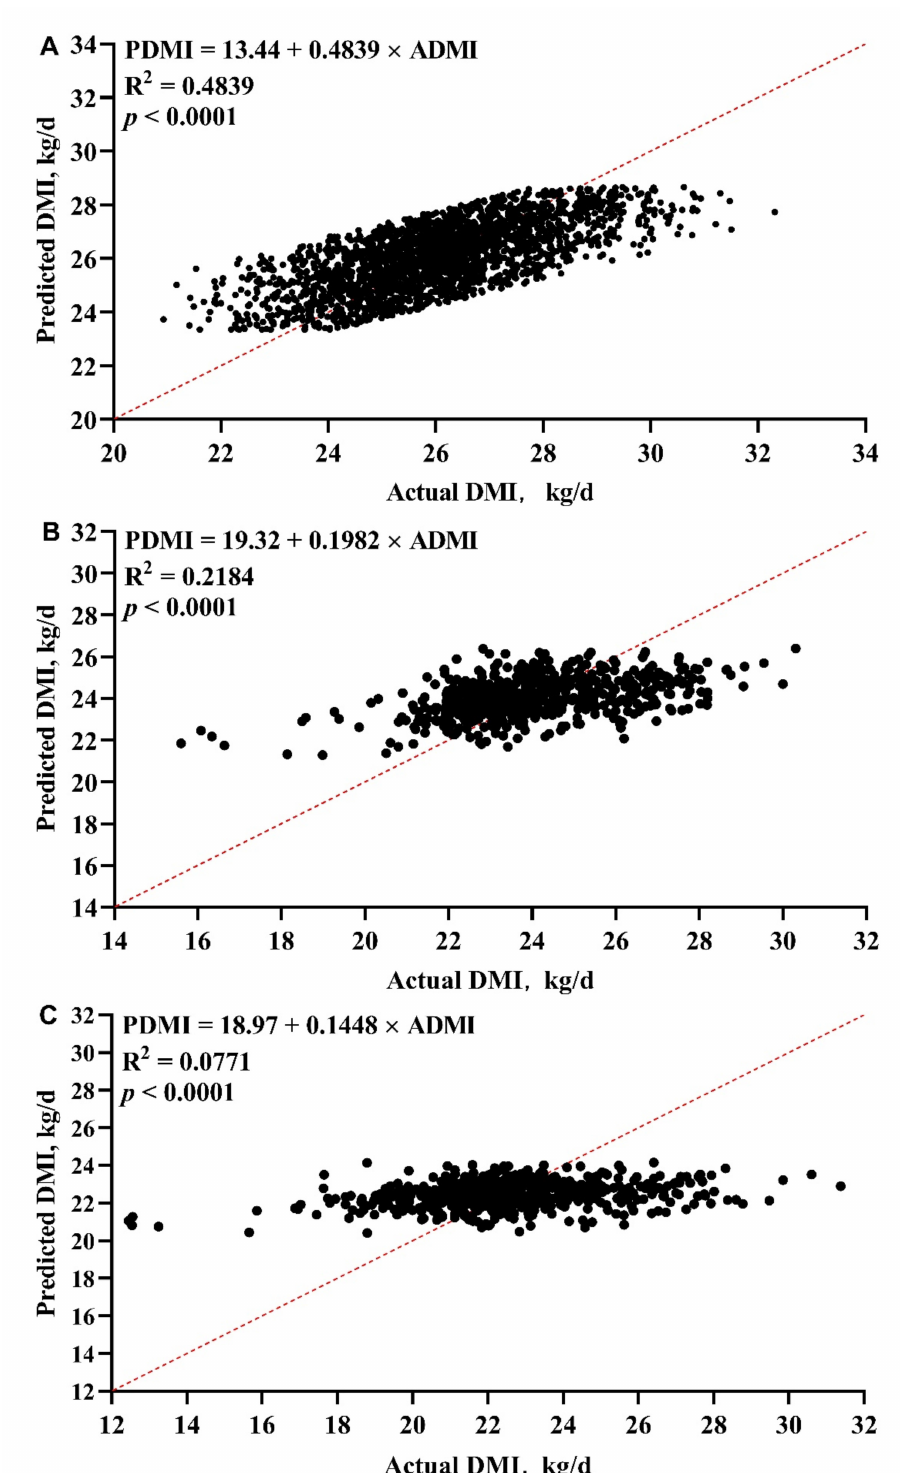
Figure 2. The regression relationship between actual dry matter intake (ADMI) and predicted DMI (PDMI) in development dataset ( A ) and validation dataset (current model ( B ) and NRC model ( C